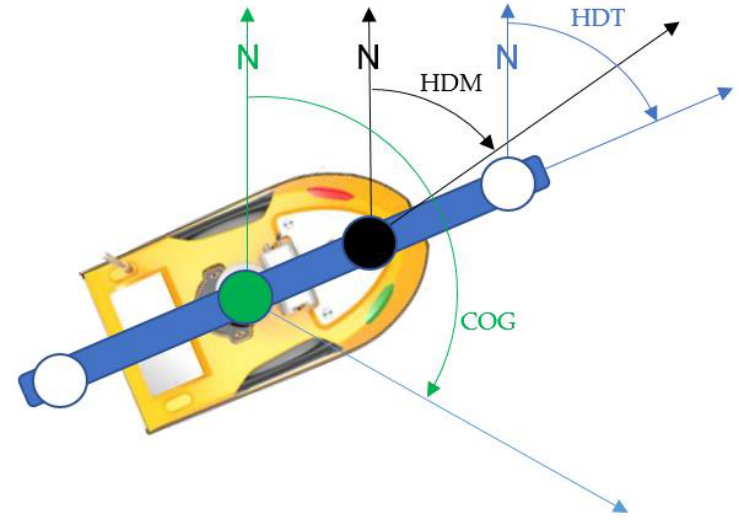
Figure 2. Relationships between headings and COG.